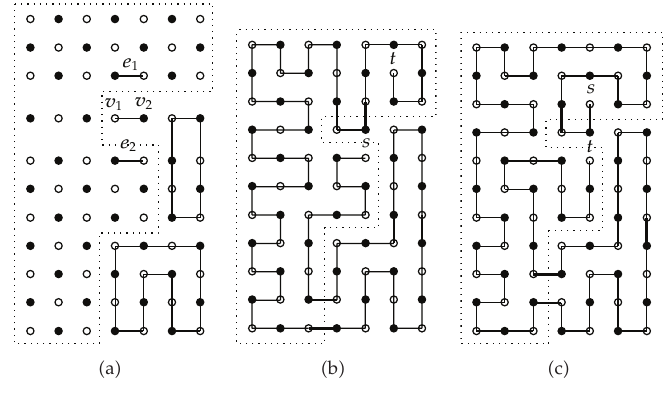
Figure 5: A Hamiltonian path in R (cid:6) 7 , 11 (cid:7)